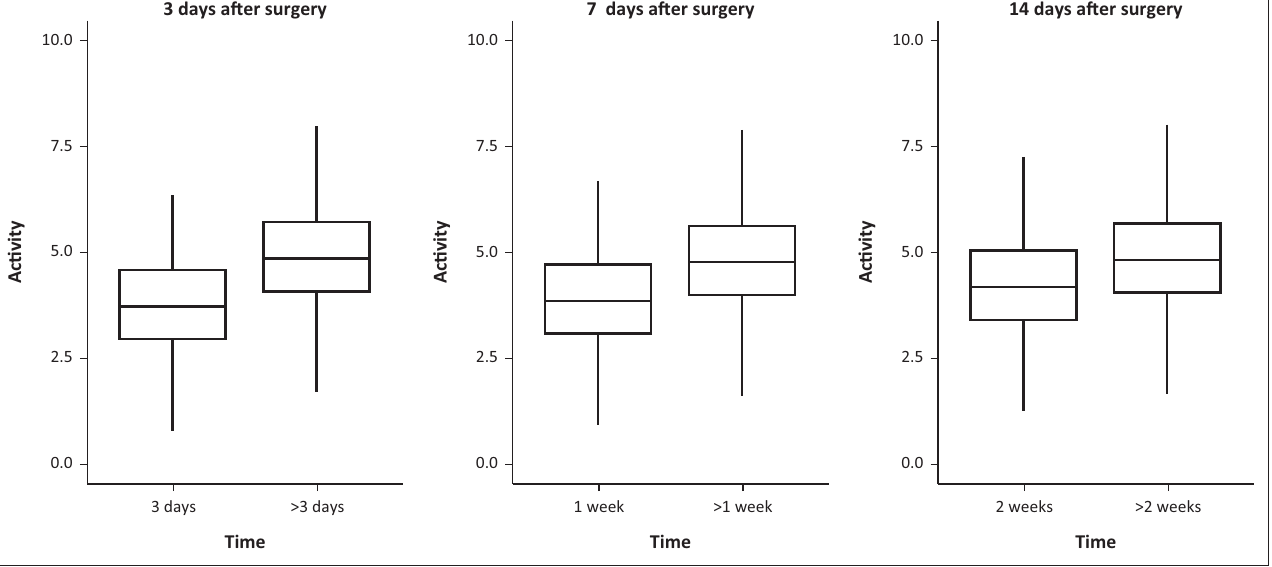
FIGURE 3: Box and whisker plots comparing the logarithmic activity rates of Hydrocynus vittatus individuals during the three potential recovery periods. The activity rates amongst the recovery periods were significantly different from the activity rates following each period ( p < 0.05). Note: Median is denoted by the thick middle line of the box. The upper and lower limits of the box represent the first and third